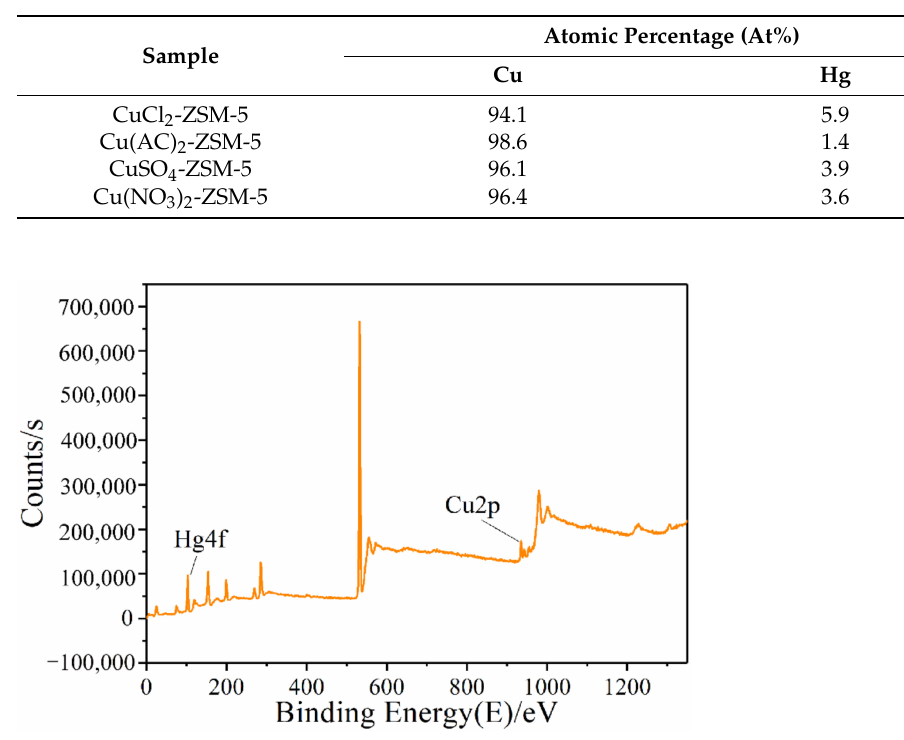
Figure 4. SEM and surface energy spectra of ( a ) 2.5% CuCl 2 -ZSM-5, ( b ) 1.5% Cu(AC) 2 -ZSM-5, ( c ) 2.5% CuSO 4 -ZSM-5, and ( d ) 4.0% Cu(NO 3 ) 2 -ZSM-5. Table 4. Element type and content of 2.5% CuCl 2 -ZSM-5, 1.5% Cu(AC) 2 -ZSM-5, 2.5% CuSO 4 -ZSM-5, and 4.0% Cu(NO 3 ) 2 -ZSM-5.